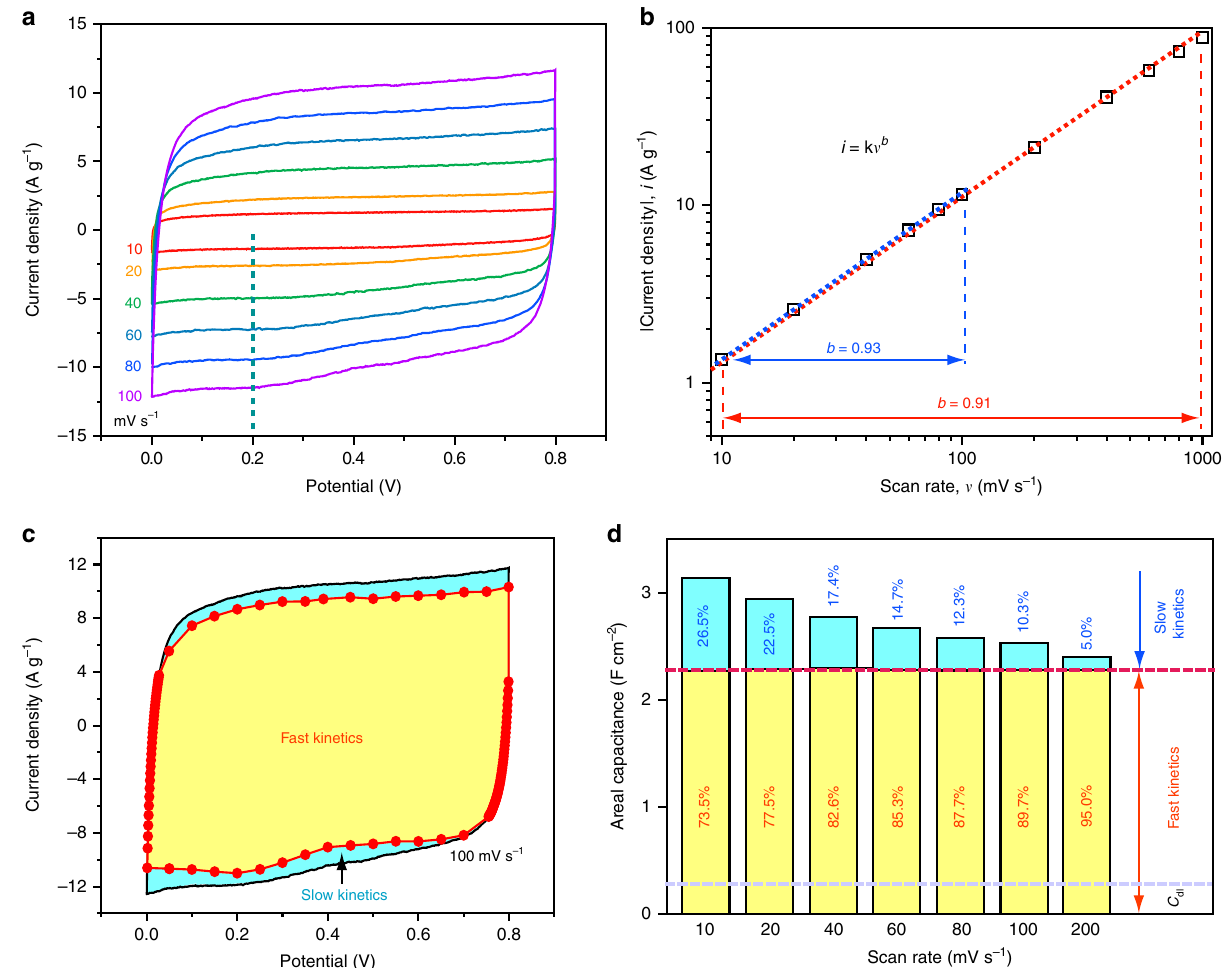
Fig. 5 Ultra-fast charge-storage kinetics of PCF@MnO 2 -2h. a CVs at various scan rates from 10 to 100 mV s − 1 . The dashed line highlights the potential (0.2 V) selected for the b value calculation. b Absolute current density and scan rate follow the power law, i = k v b , in both the slow and fast scan rate regions. The dashed lines are best fi tting lines and the b -value changes only slightly from the slow scan region to the fast scan region. c Decoupling of the capacitance contributed by the fast-kinetic processes (yellow) and the slow-kinetic processes (blue). Even at a high mass loading of MnO 2 (50% of the total mass), the fast-kinetics capacitance still dominates the overall capacitance. d Histograms of the capacitance contributions by the different processes: Yellow, fast-kinetic processes; blue, slow-kinetic processes; C dl , electrical double layer